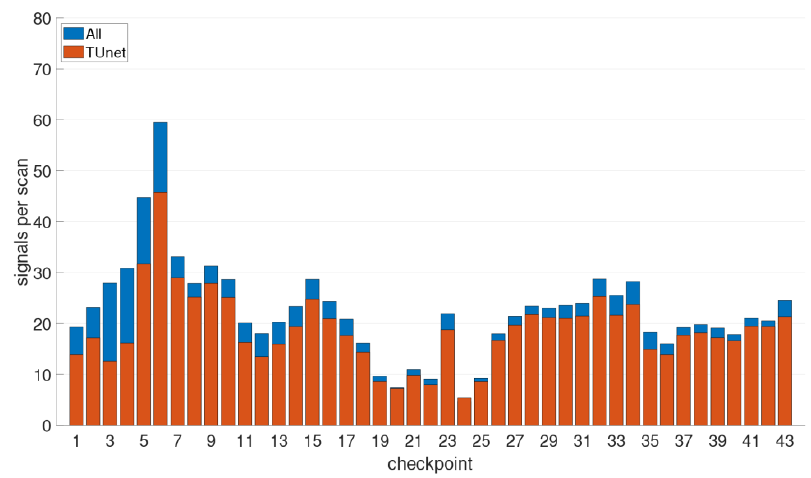
Figure 2. Average number of visible signals per scan on all checkpoints of the trajectory leading from outside through the ground floor to the reading room on the second floor.